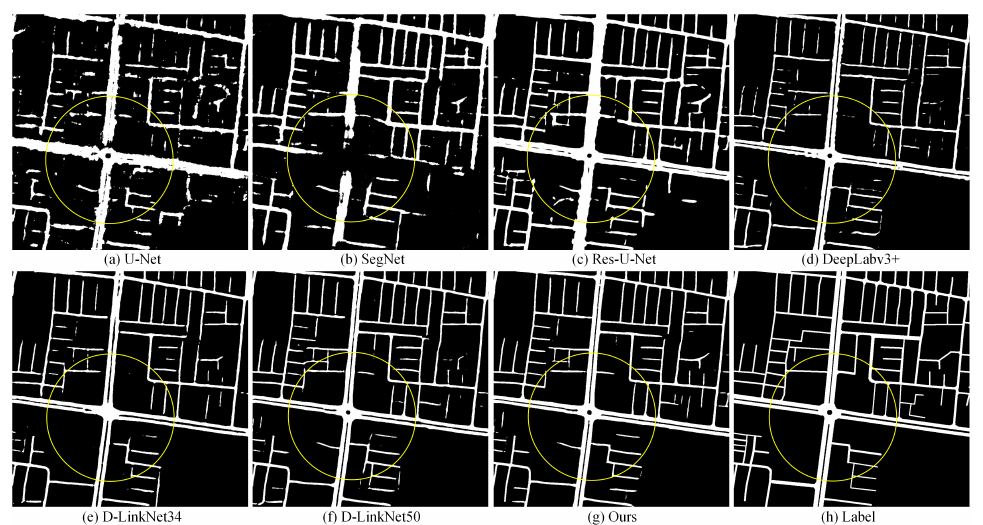
Figure 11. Extracted samples of related methods on the DeepGlobe dataset.